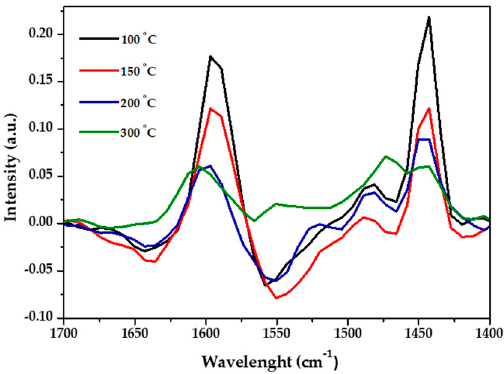
Figure 3. DRIFT spectra of pyridine adsorption at different temperatures on the α -Fe 2 O 3 /RH-Silica material.